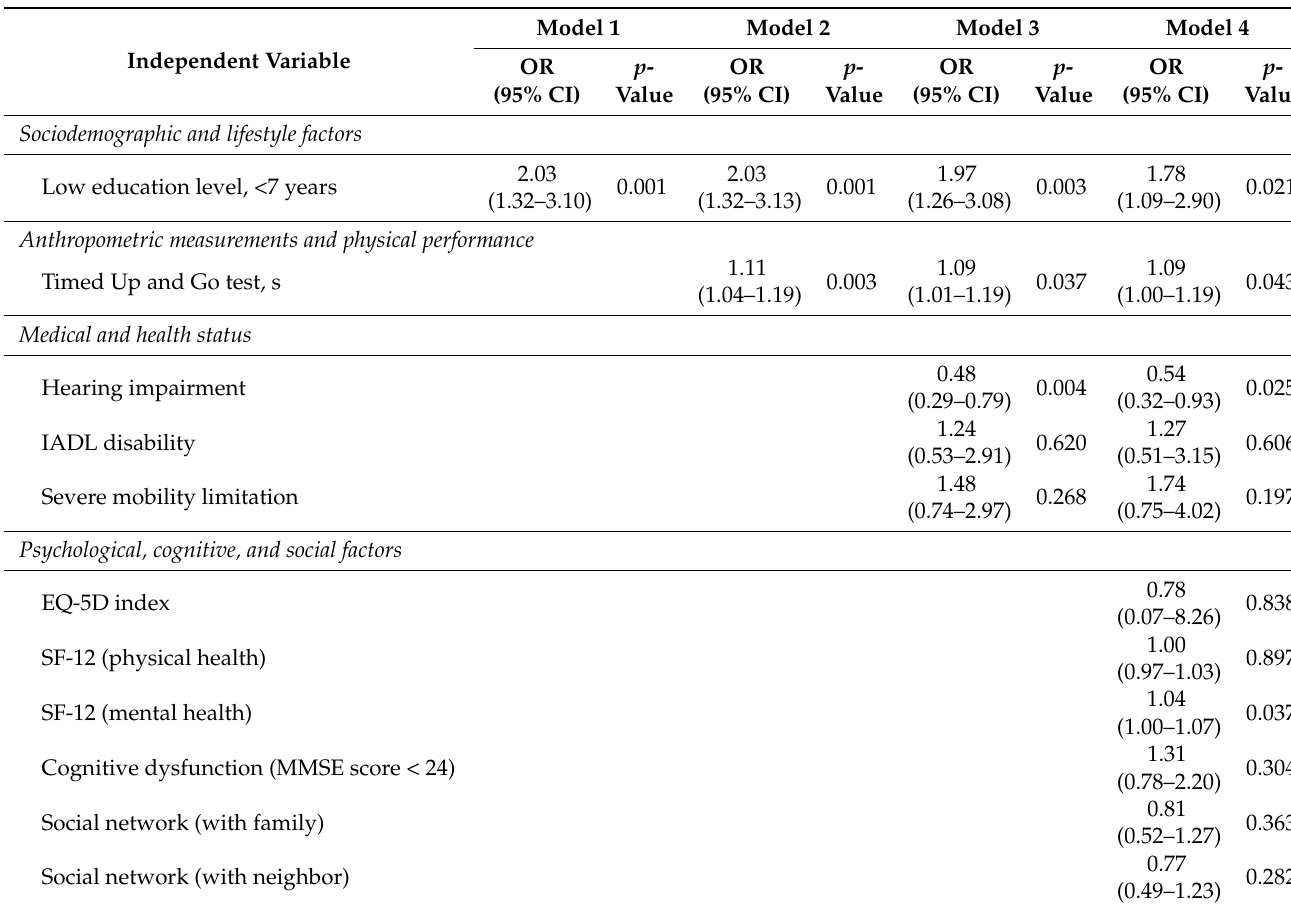
Table 2. Adjusted odds ratios of variables for predicting possible sarcopenia compared with sarcope- nia in